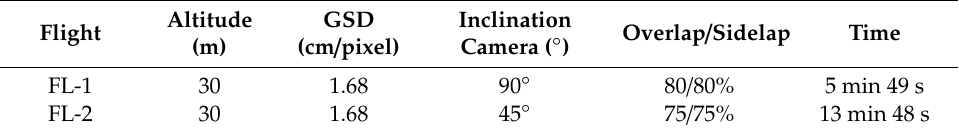
Table 1. Main features of the performed flight missions.